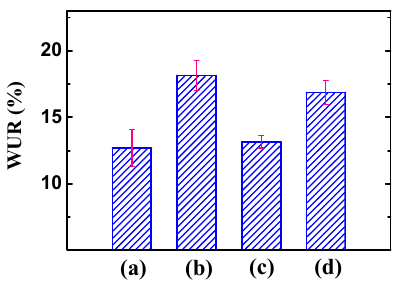
Figure 3. WUR of the prepared membranes. ( a ) Pure Nafion layer; ( b ) SCNT/Nafion hybrid layer; ( c ) pure Nafion matrix membrane; ( d ) SCNT/Nafion composite matrix membrane.